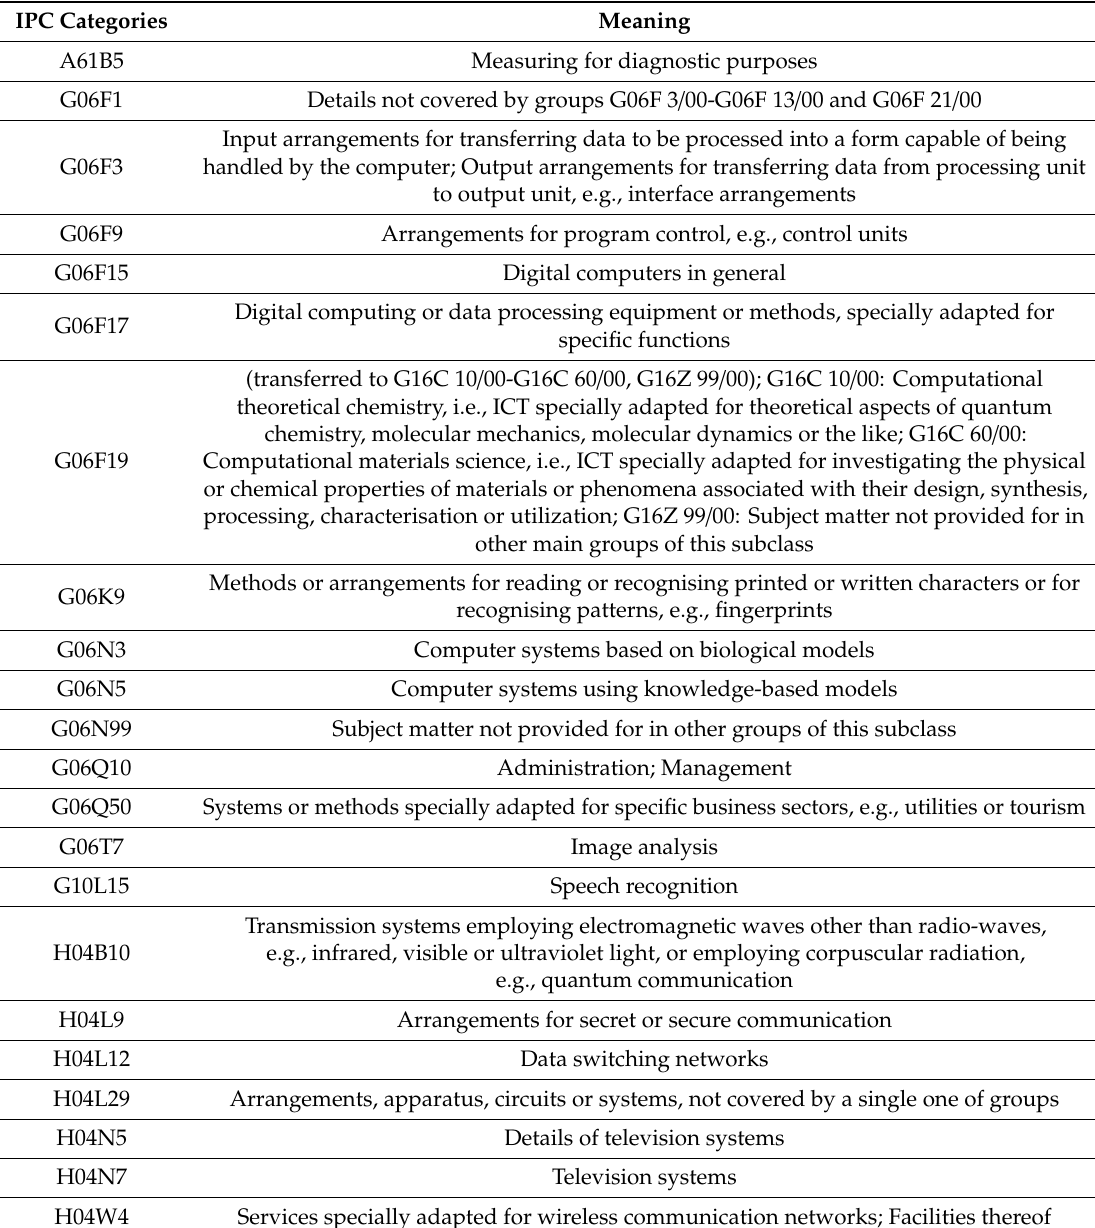
Table A1. Definition of IPC